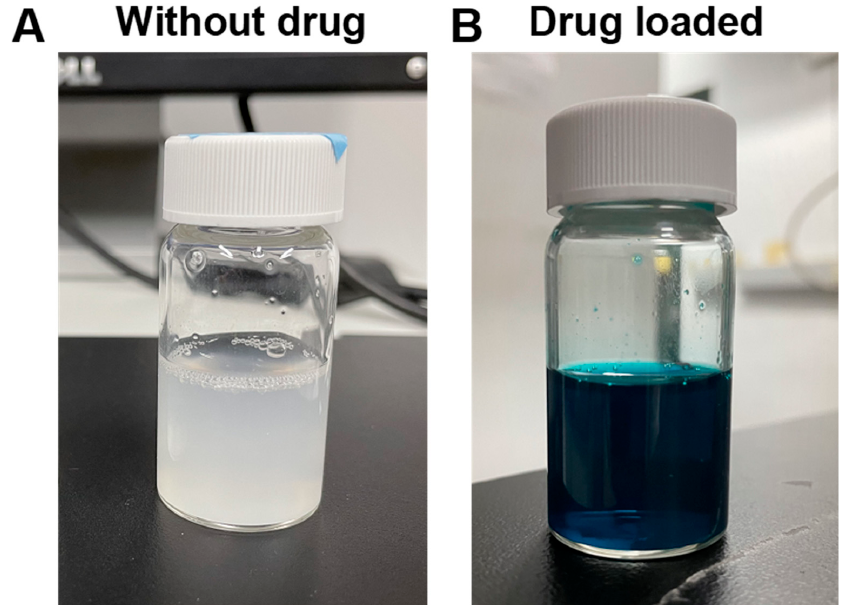
Figure 8. Photo images showing the suspension of composite nanoparticles based on AdSP and chitosan without model drug ( A ) and those loaded with drug ( B ). chitosan without model drug ( A ) and those loaded with drug ( B